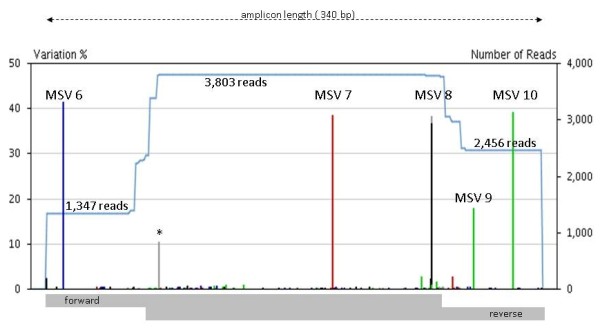
Graphical output of the GS Amplicon Variant Analyzer for the assembly of sequences as exemplarily shown for NA15029, amplicon F5. Left Y-axis: minor allele frequency; MSV colour code: blue = C; red = T; black = G; green = A; asterisk: insertion/deletion 454 sequencing artefact within a poly-A stretch; blue curve: read coverage; grey bar below: average lengths of forward and reverse reads, respectively.